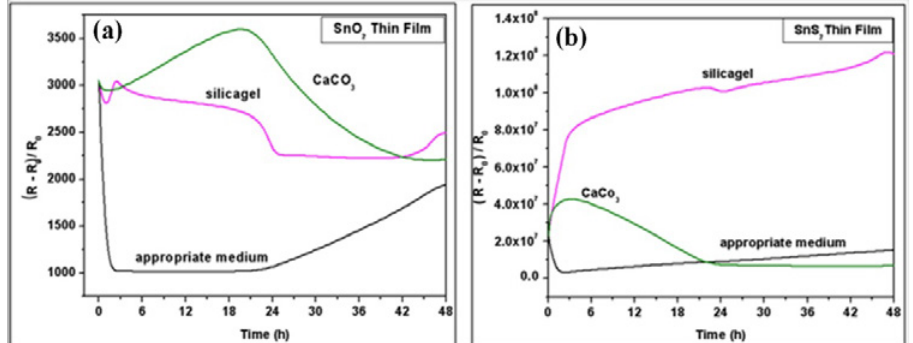
Fig 4. plot variation resistance according to temperature for a) SnO Fig 4: plot variation resistance according to temperature for a) SnO 2 thin film and b) SnS 2 thin film